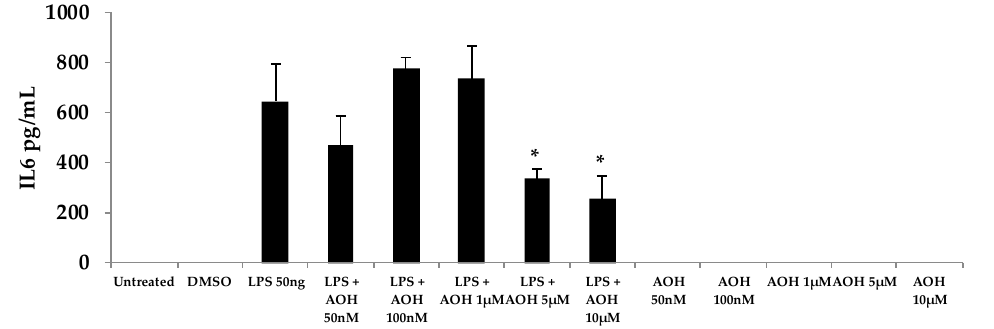
Figure A3. Dose-dependent response of mouse macrophages (RAW264.7) after treatment with alternariol (AOH) and lipopolysaccharide (LPS). Cells were treated with 50–10 μ M of AOH in the presence and absence of 50 ng of LPS to measure the IL6 levels released by enzyme-linked immunosorbent assay (ELISA). Cell densities were 5 × 10 5 cells/well, and they were incubated for 24 h under normal conditions at 37 °C, 5% CO 2 after treatment. An * indicates p < 0.05 according to Student’s t -test when comparing LPS + AOH treatments to LPS-induced control.